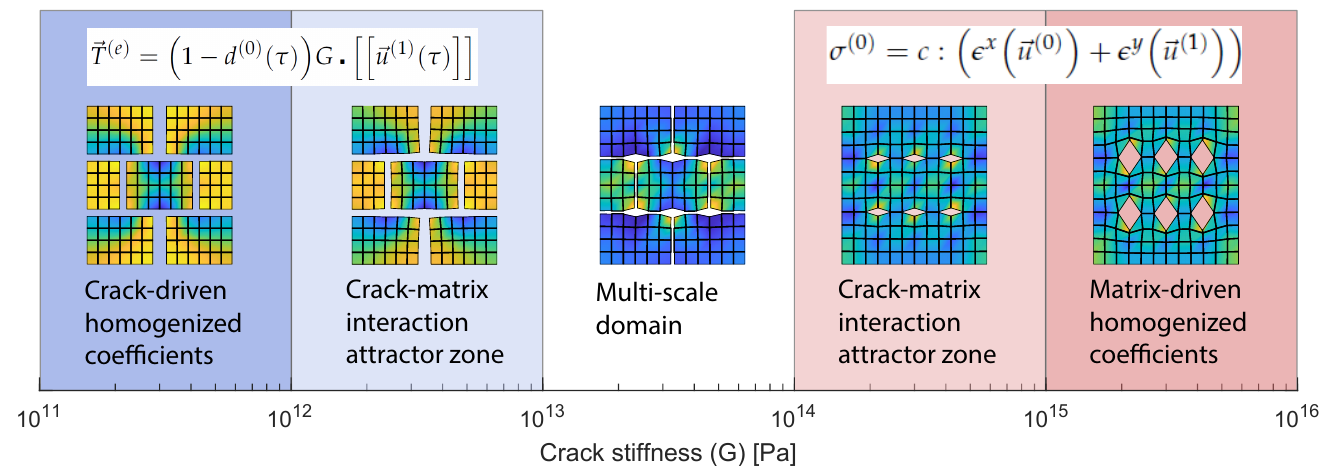
Figure 9. Micro-scale configuration crack stiffness range using von Misses failure